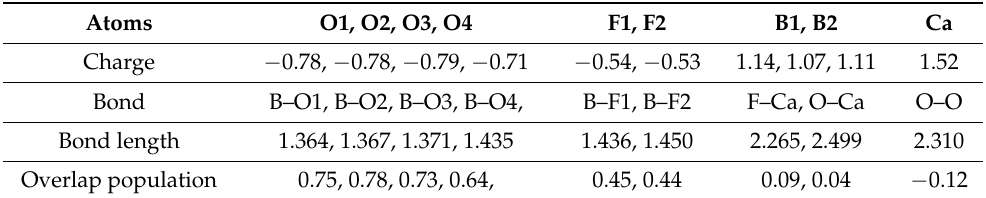
Table 2. Comparison of the overlap populations between the atoms and charges for each atom in